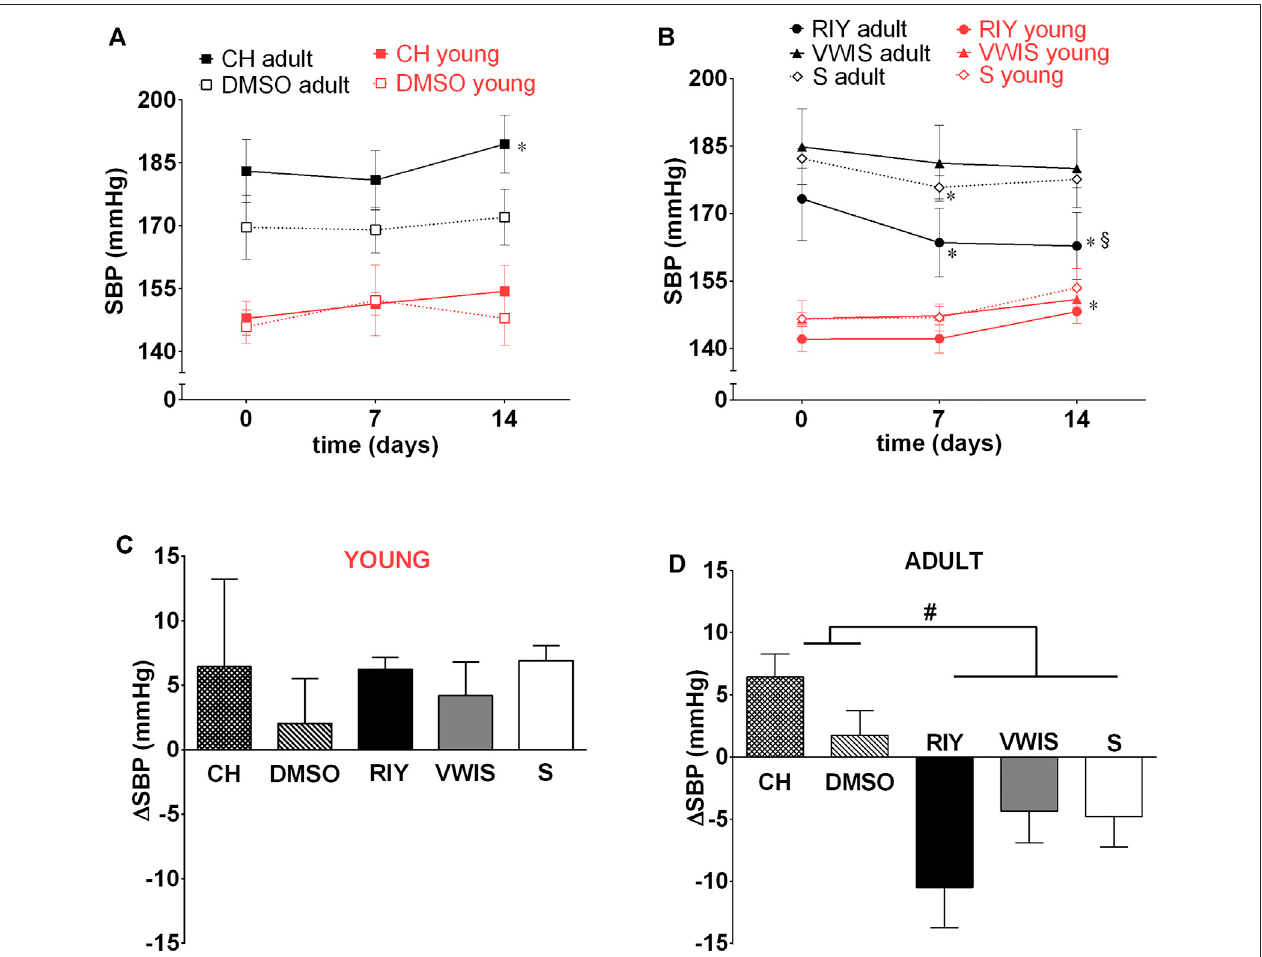
FIGURE 3 | Systolic blood pressure (SBP) measured on 0, 7th and 14th day in young and adult spontaneously hypertensive rats (SHR) receiving intravenous treatment with (A) chymostatin (CH, 2 mg/kg/day, young: n (cid:1) 5, adult: n (cid:1) 8) and its solvent (0.15% DMSO, young: n (cid:1) 5, adult: n (cid:1) 5) (B) peptides RIY (7.5 mg/kg/day, young: n (cid:1) 6, adult: n (cid:1) 5), VWIS (12.5 mg/kg/day, young: n (cid:1) 5, adult: n (cid:1) 6) and their solvent – saline (S, young: n (cid:1) 5, adult: n (cid:1) 5); (C) overall change in SBP ( Δ SBP betweenday0and14)inyoungand (D) adultanimals;* p < 0.05signi fi cantlydifferent vs. baselinevalueonday0withinthesamegroup;§valueinRIY vs. CHgroup onday14th( p < 0.05;multivariateanalysisofvarianceANOVAwithrepeatedmeasurements,followedbyDuncan ’ s post-hoc test);# p < 0.05signi fi cantlydifferentvalues between indicated groups (one-way ANOVA, followed by Duncan ’ s post-hoc test).